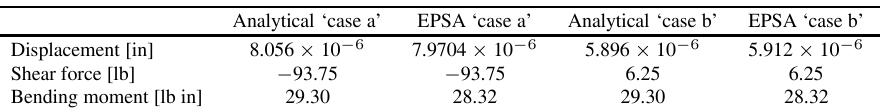
Table 1 Comparison of results (all values at point A )